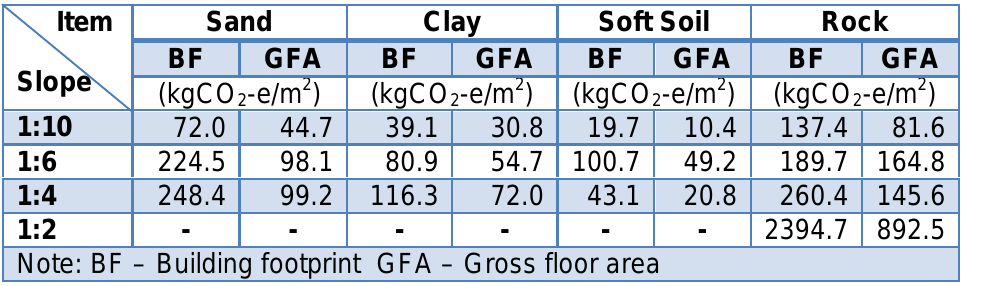
Table 4: Average GHG per m 2 of building footprint and gross floor area by soil and slope types